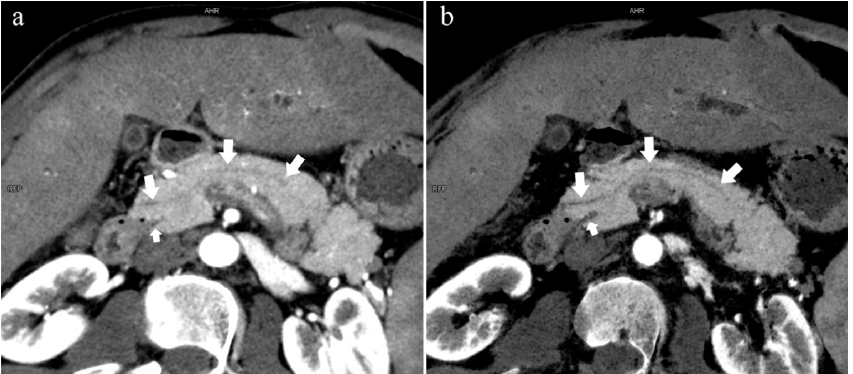
Figure 6. Type 4b. A 46-year-old male patient with hilar cholangiocarcinoma. ( a ): MIP [45keV MEI(+)] shows that the MPD (long arrow) flows into the MiP and extends to the tail. APD is not shown. The initial part of the common bile duct (short arrow) is visible. ( b ): MinIP [45keV MEI(+)] shows the course of the pancreatic duct more clearly. MPD refers to anatomically large and functionally dominant ducts.